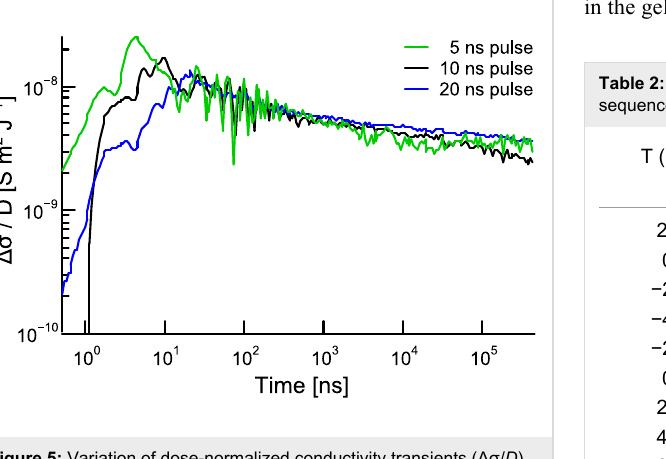
Figure 5: Variation of dose-normalized conductivity transients ( Δσ / D ) with time for T1 .